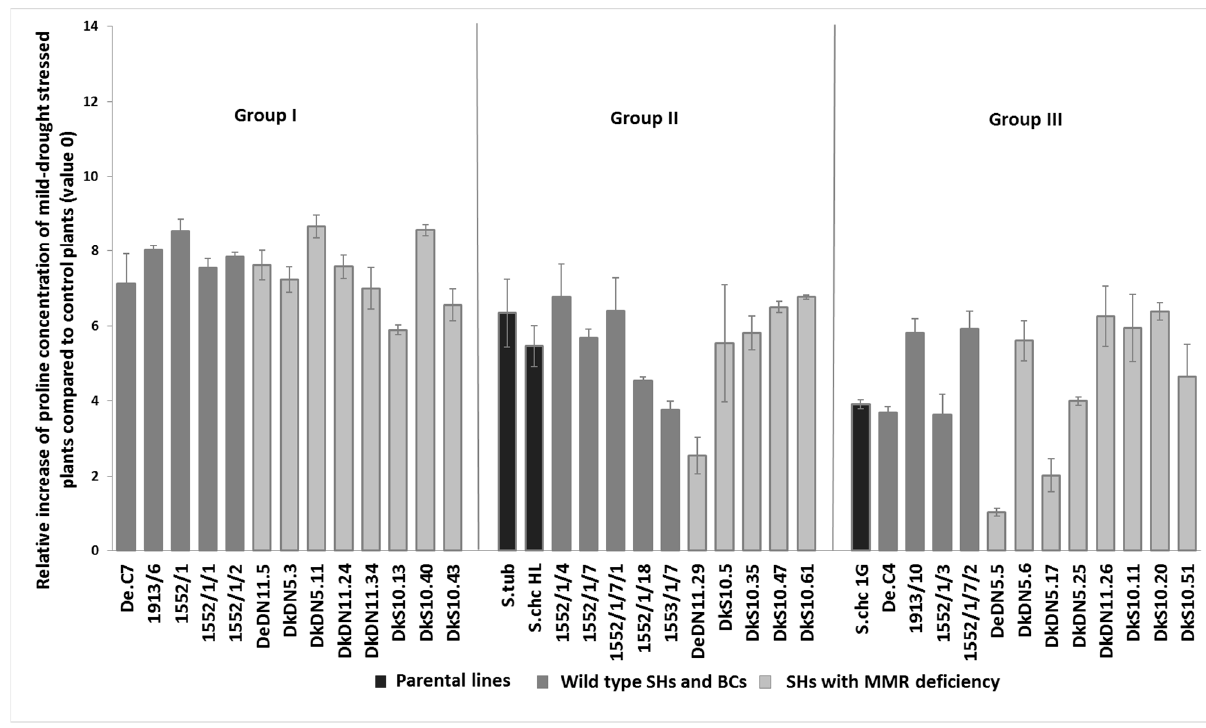
Figure 4. Relative proline concentration changes (mean ± SE, n = 5) during moderate water stress of different SHs with or without MMR deficiency, BC progenies, and parental lines ( S. tuberosum cv. Delikat and S. chacoense — S.chc HL or 1G).